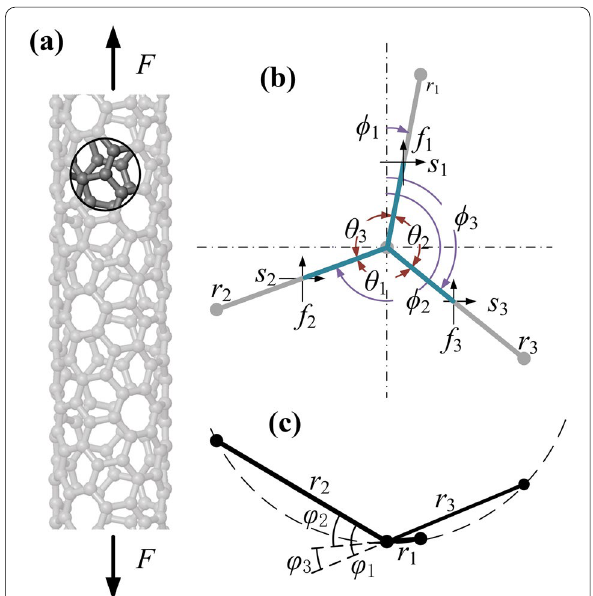
Figure 3 The geometric parameters of a chiral CNT in the stick-spiral model [56]: ( a ) global structure, ( b ) front view and ( c ) top view of local